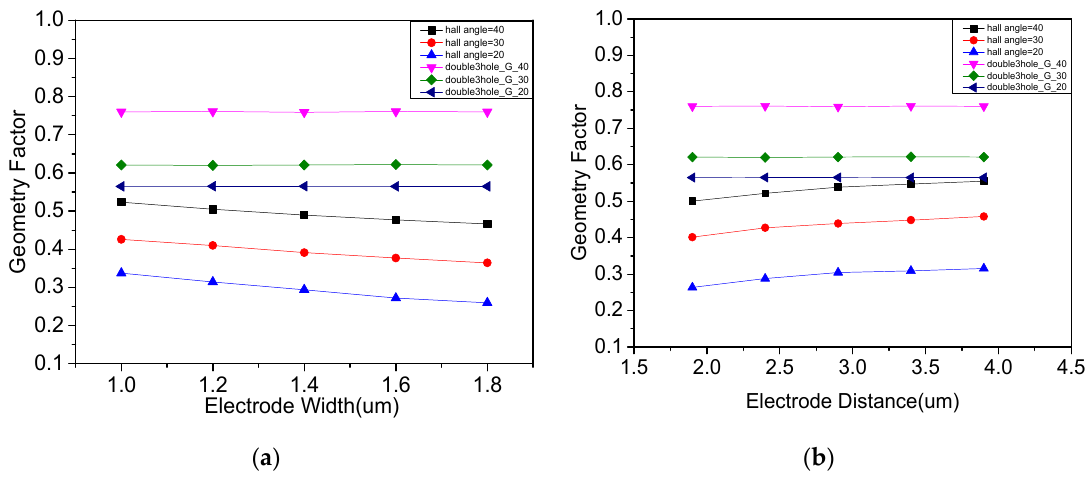
Figure 6. The analysis results: ( a ) effect of width of virtual electrode on device performance; ( b ) effect of position of virtual electrode on device performance.